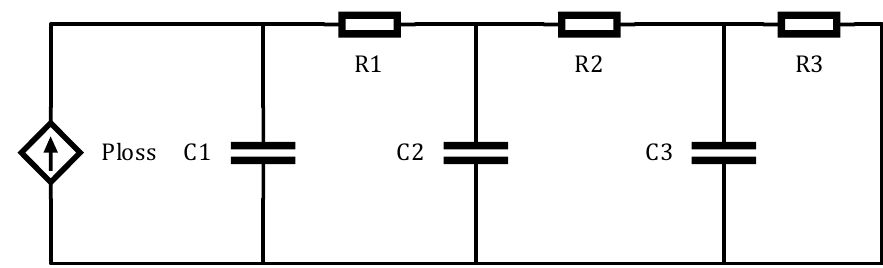
Figure 15. Third-order Cauer-type thermal network.